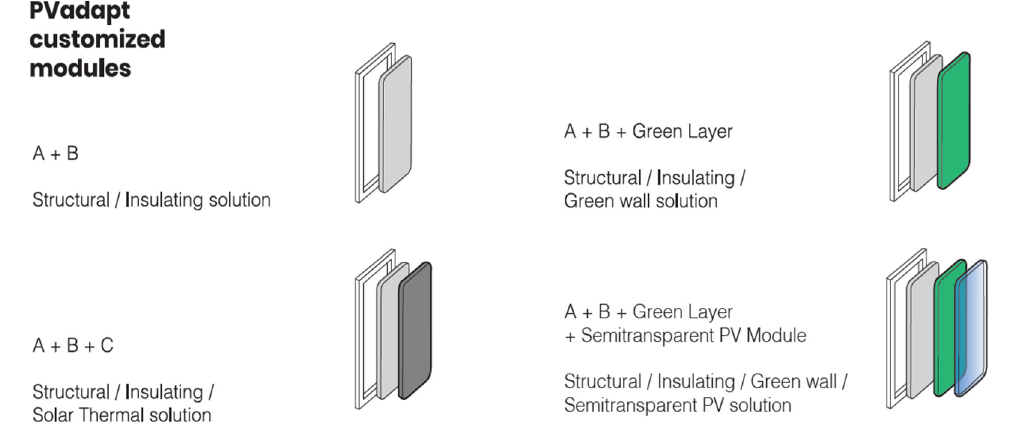
Figure 2. Concept of the four customized modules developed for the purposes of the PVadapt